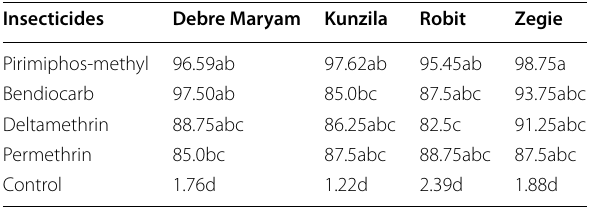
Table 2 Effect of different insecticides on the mortality of An. gambiae s.l. at different locations in Lake Tana area of